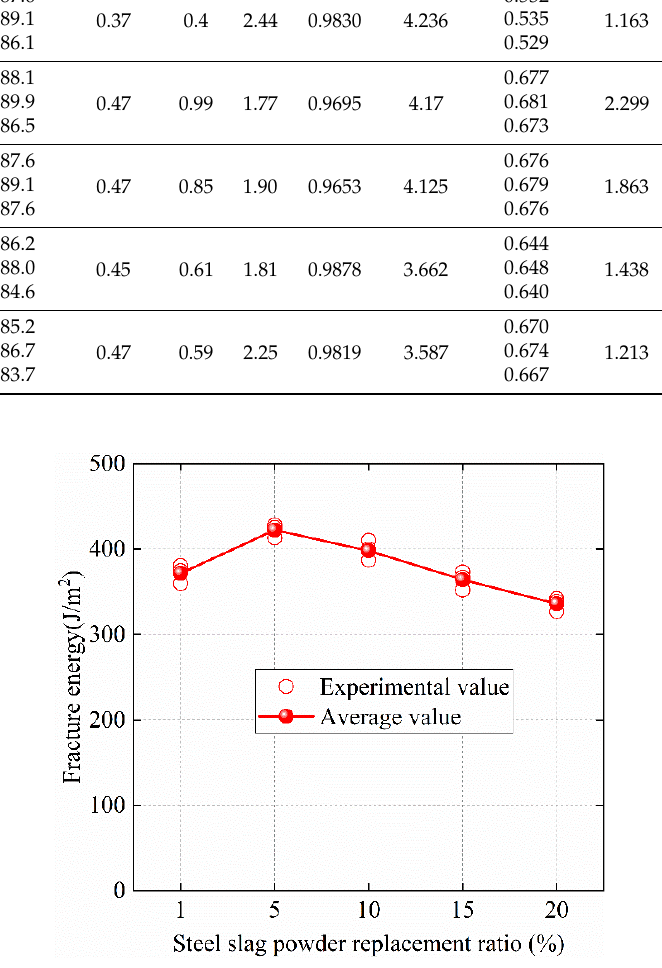
Figure 6. Fracture energy of